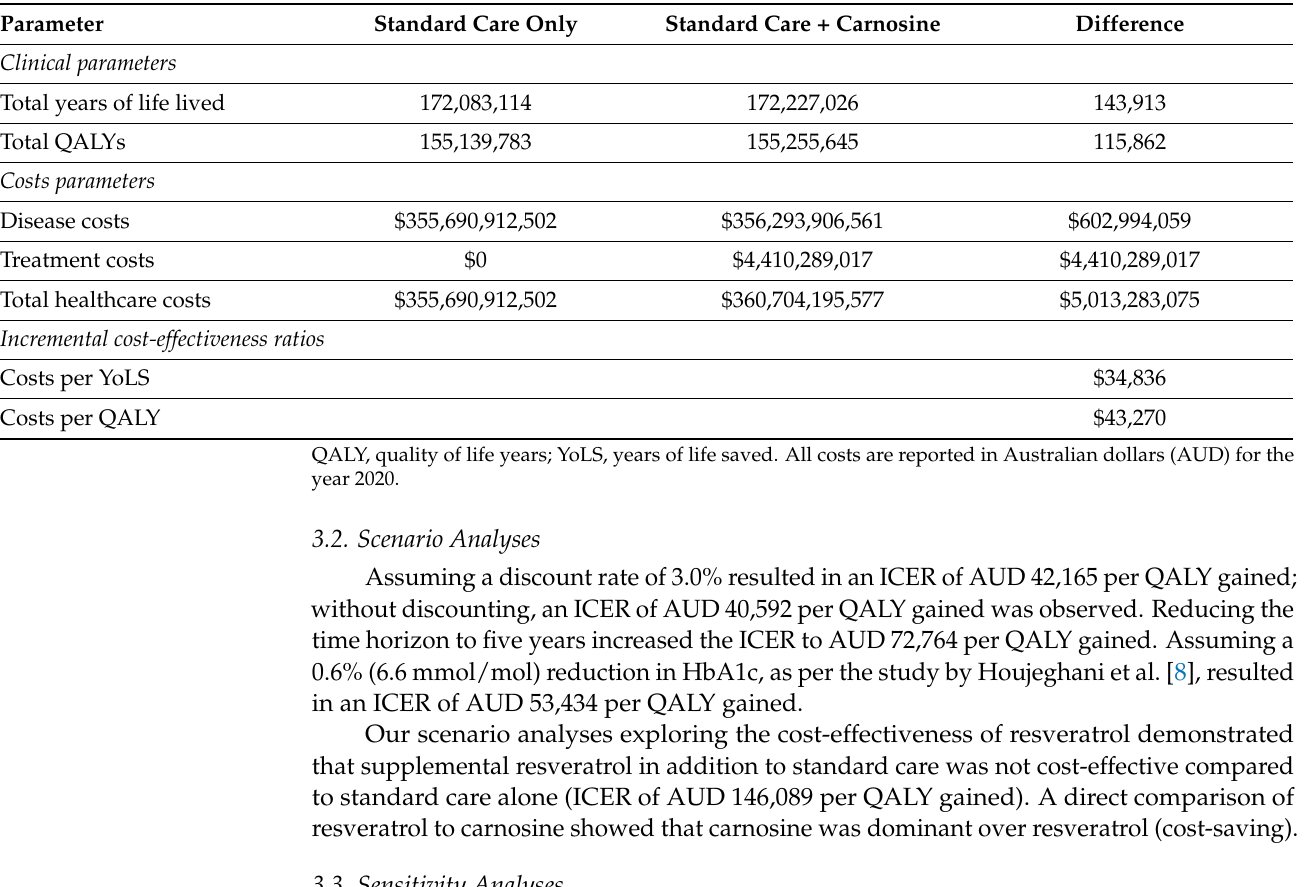
Table 2. Base case results for the total Australian population aged >18 years, with type 2 diabetes treated with carnosine plus standard care, compared to standard care alone over ten